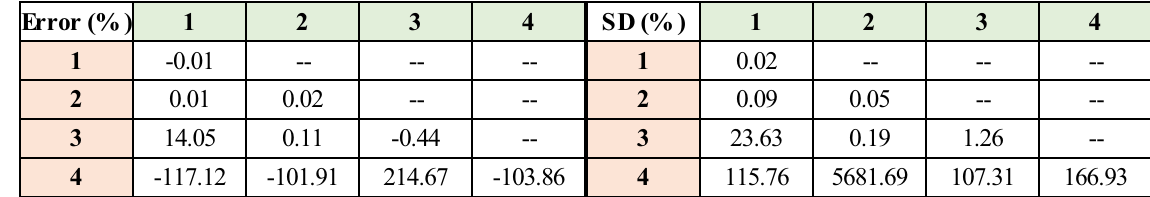
Figure 3. P1 Scattering Matrix Error, MCS vs. SERPENT 2.